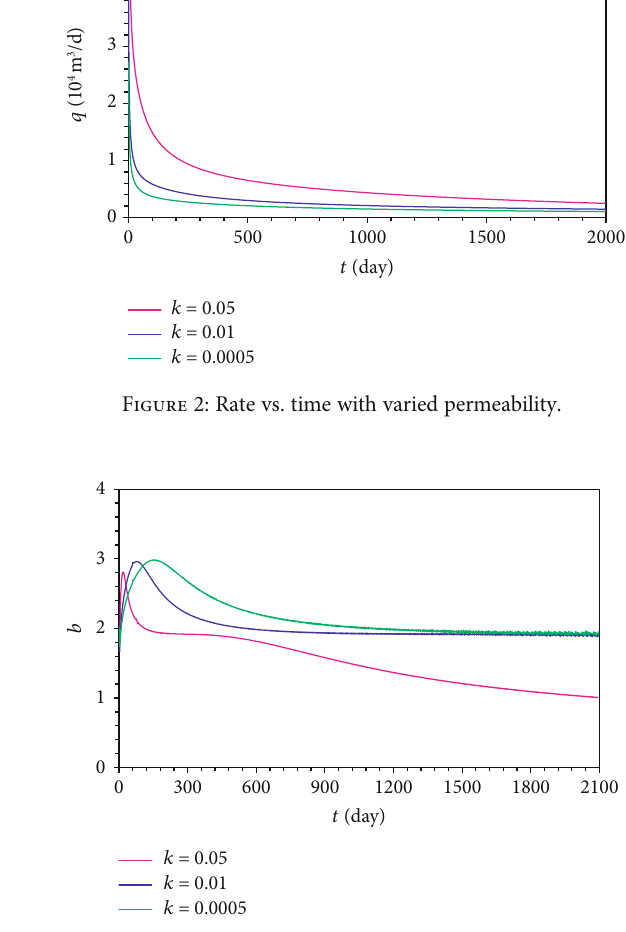
Figure 3: Decline exponent b vs. time with varied